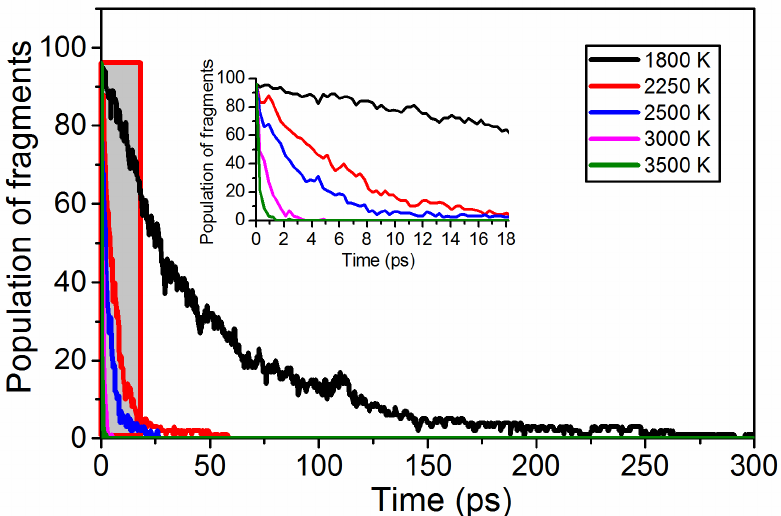
Figure 7. The population of TNTA molecules over time during the whole decomposition stage at the five extreme conditions.